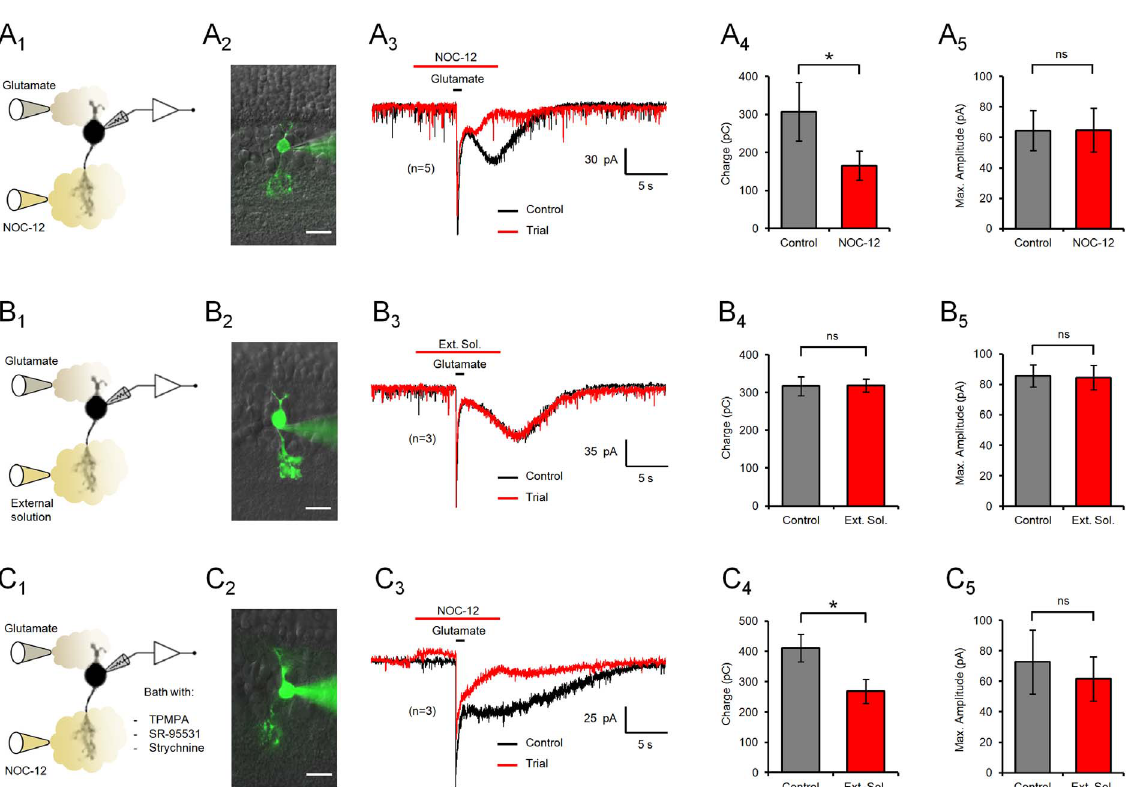
Figure 2. NO modulation of glutamate responses in type 4 CBCs. (A) Representative recordings of glutamate responses of a type 4 OFF CBC, clamped to –60 mV. The experimental setup (A 1 ) and an image of the lucifer yellow-filled recorded cell (A 2 ) are shown to the left. (A 3 ) Application of NO donor NOC- 12 (200 m M) only affected the slow component of the glutamate response, by shortening the duration of the electrical response. Bars indicate the stimulus duration. (A 4 ) Bar diagrams displaying the mean ¡ SEM of the total charge transferred during the glutamate response, with and without NO stimulation. (A 5 ) The maximum amplitude of the glutamate response, measured at the peak of the fast component, remained unaffected by NO. (B) Control experiments with puffs of extracellular solution instead of NOC-12 were ineffective, demonstrating the absence of stimulus or pressure artifacts. (C) Bath application of the GABA A and GABA C receptor antagonists SR-95531 and TPMPA, and the glycine receptor blocker strychnine did not affect the modulation of the glutamate response by NO in type 4 CBCs. Image scale bars 5 10 m m; ns 5 not significant.